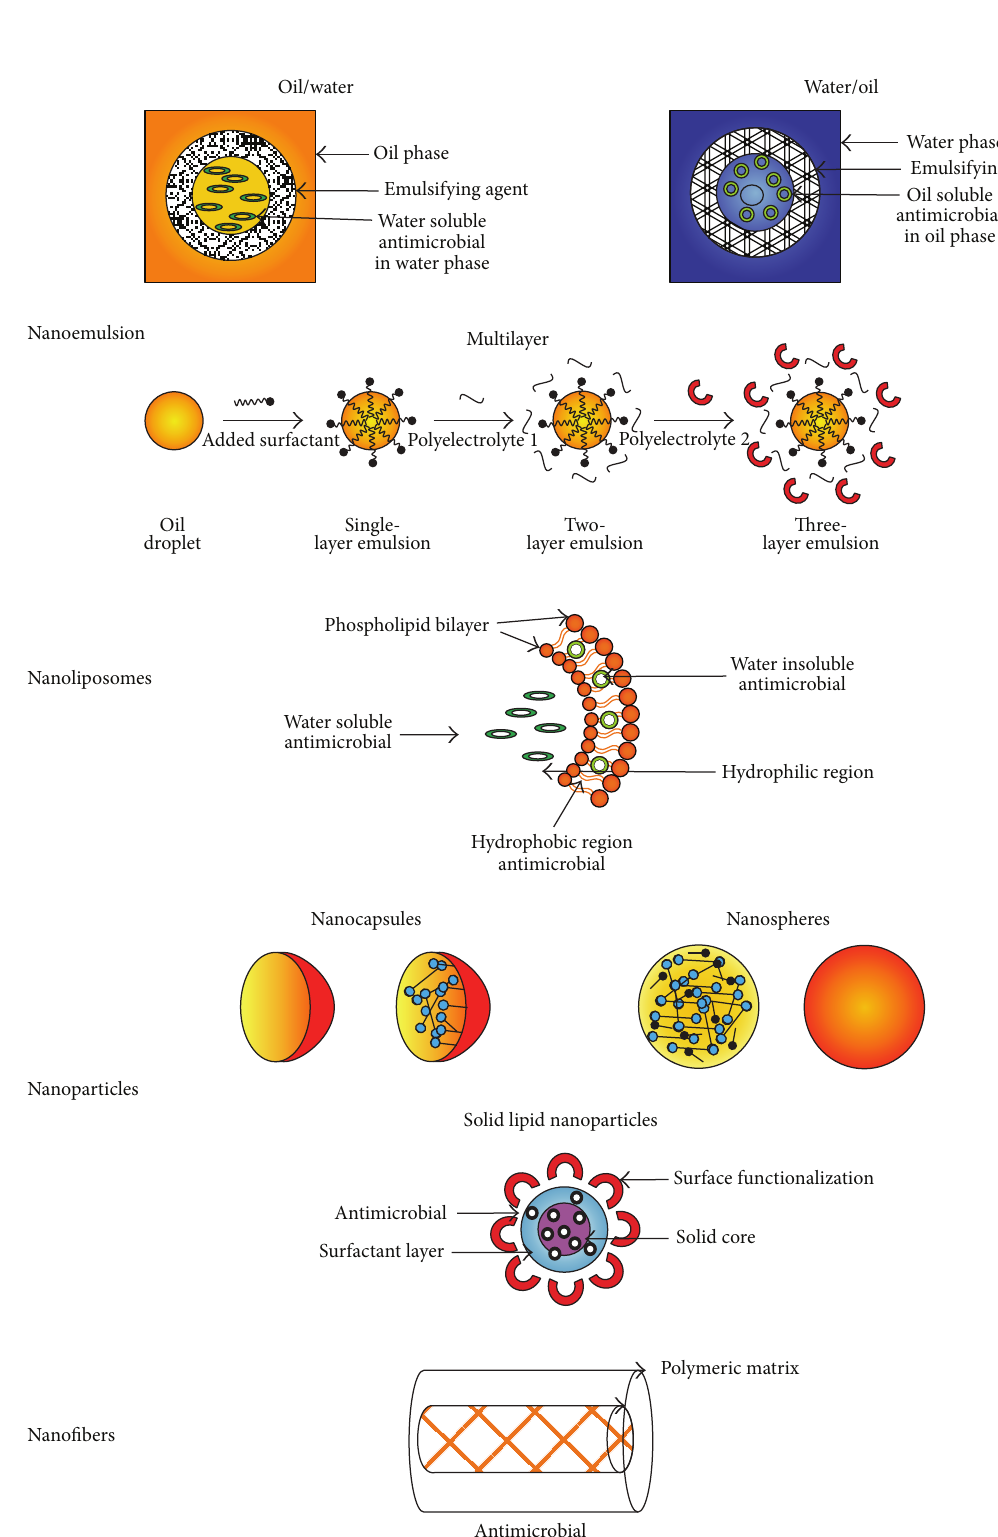
Figure 1: Structures of nanoscale delivery systems used to entrap food